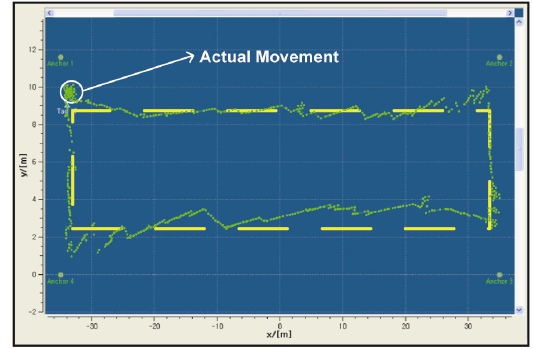
Fig. 8. Vehicle movements in the 70 metre